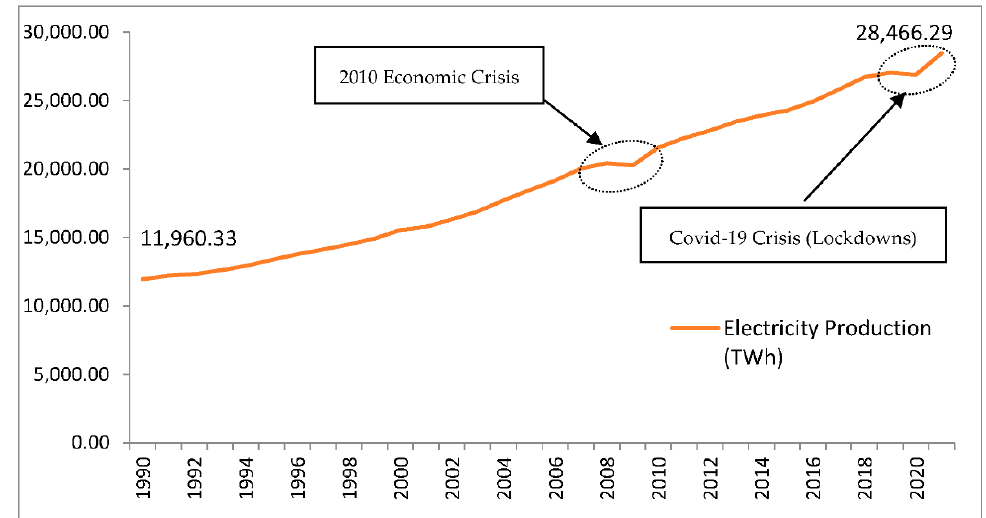
Figure 4. Total electricity production worldwide 1990–2021 (TWh)—data source: BP statistical review of world energy [72].